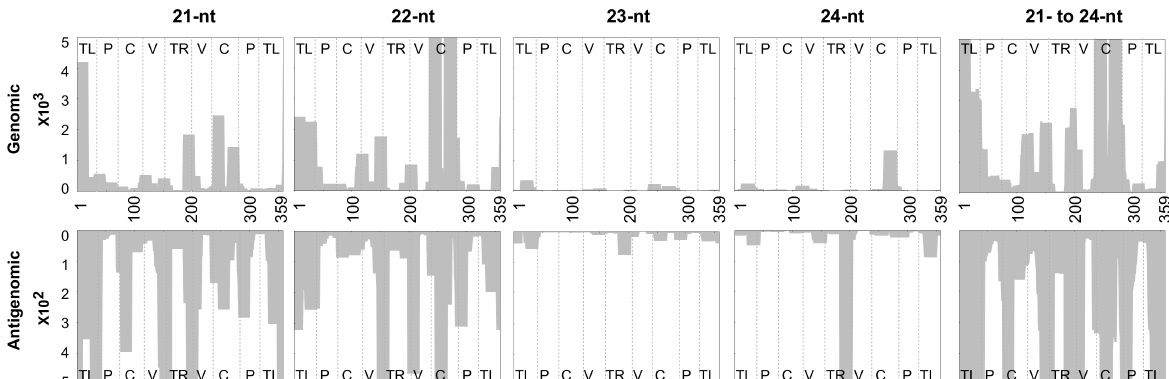
Figure 2. Profiling of the vd-sRNAs recovered from PSTVd-I-infected tomato plants at zero mismatches. Sequence profiles of the (+) and the ( − ) PSTVd-sRNA populations recovered from the leaf tissues of infected tomato plants. The data were normalized to reads per million. In the figure, different structural regions of PSTVd are delimited by dashed lines (from left to right, TL, terminal left; P, pathogenicity; C, central; V, variable; and TR, terminal right).